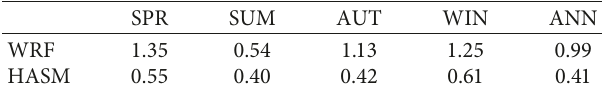
Table 2: Root-mean-square error (RMSE) values of the WRF model and HASM.